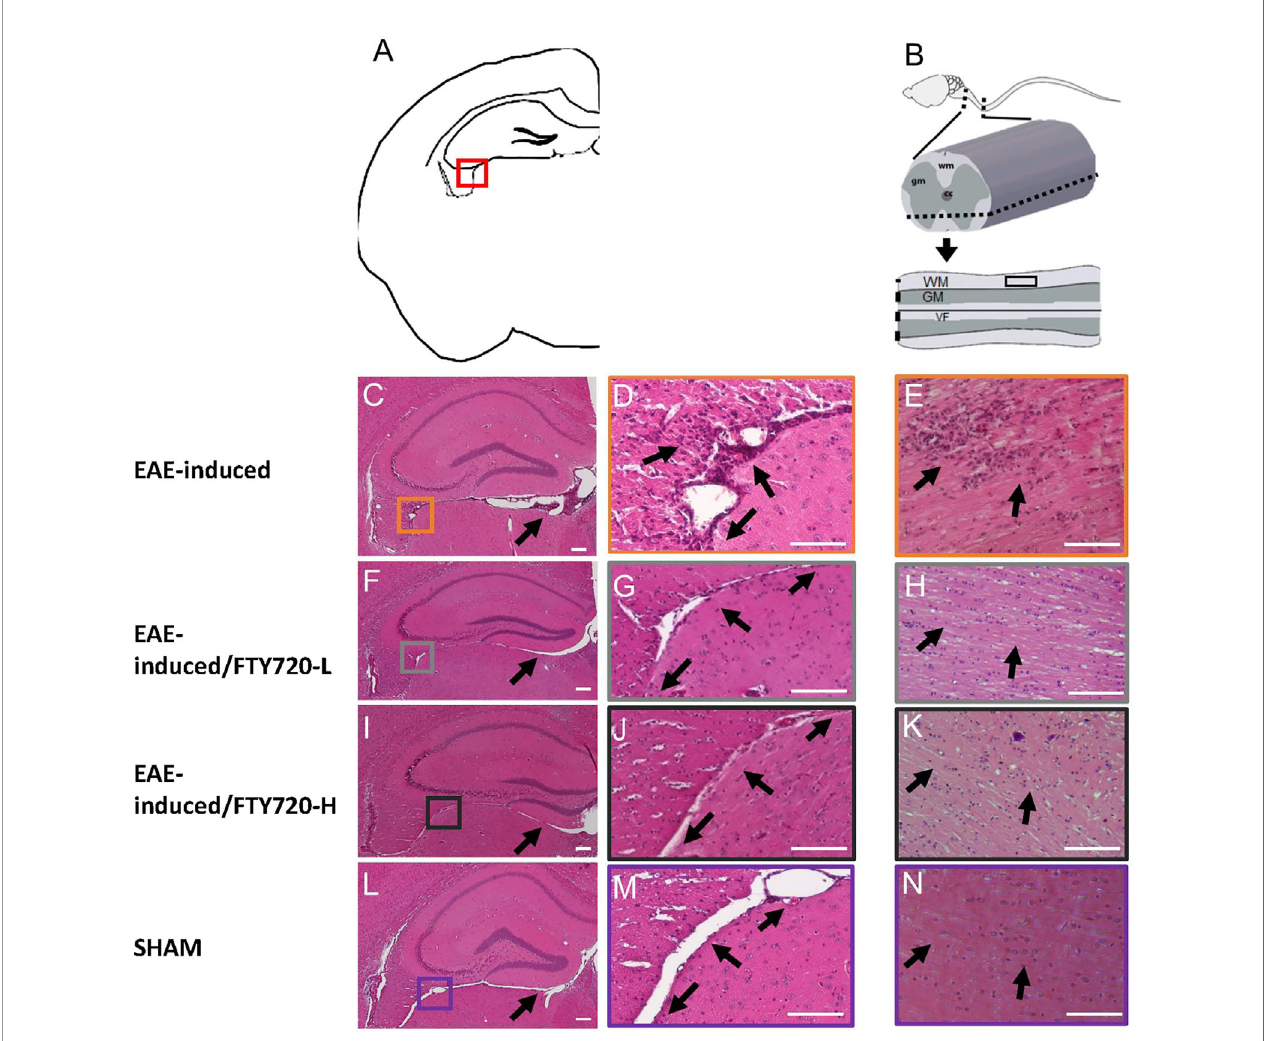
FIGURE 1 | Effect of FTY720 on in fl ammatory in fi ltration into the CNS. (A) is a schematic of the brain region of interest, with the red box indicating the fi mbrium region (also in C, F, I, L ). All images were taken at 14 dpi. (C, D) show representative HE-stained sections from the EAE-induced, untreated group. (F, G, I, J) show representative images of the EAE-induced FTY720-treated (F, G = FTY720-L and I, J = FTY720-H) groups and (L, M) representative sham sections. B is a schematic of the spinal cord region of interest, with the dotted line showing the level of sectioning and the black rectangle the region shown in (E, H, K, N) E = EAE- induced, H = EAE-induced/FTY720-L, K = EAE-induced/FTY720-H, N = sham. Scale bar = 150 µm; n = 4 mice/group x 3